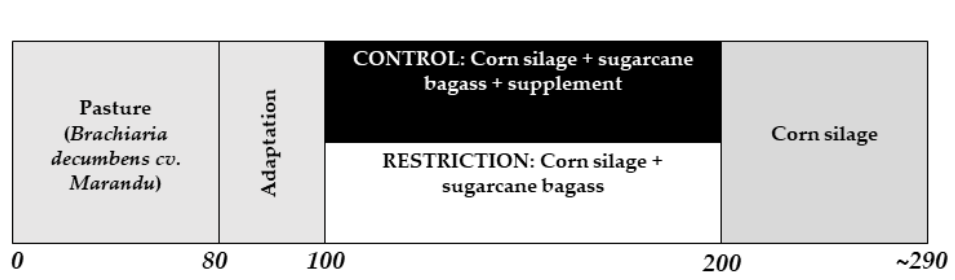
Scheme I. Scheme showing the period of the dietary treatments according to the gestational timeline. The cows were confined in individual pens (20 m 2 ) and submitted to an adaptation period of 20 days. The treatments were applied from day 100 of gestation to day 200, representing the mid-gestation. Experimental diets were offered in the form of total mixture ration (TMR) and consisted in treatment control (CON; female = 4; male = 5), where the cows were fed a basal diet plus a protein supplement at the level of 0.35% of the body weight (3.5 g/kg/day); and treatment restricted (RES, female = 6; male = 3), where the cows were fed a basal diet ad libitum of roughage (corn silage and sugarcane bagasse) containing low crude protein (CP) and a high neutral detergent fiber (NDF) content. The protein supplement consisted of a 50:50 mixture of soybean meal and a commercial supplement (40% CP; Probeef Proteinado Sprint ® , Cargill Nutriç ã o Animal, Itapira, SP, Brazil). Table 1 contain the composition of the diets. Table 1. Chemical composition (mean) of the diets offered to the pregnant cow during mid-gestation and finishing diet offered to the offspring.